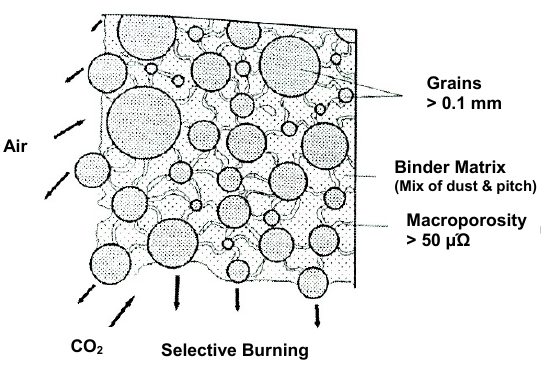
Figure 2. Anode consumption in the pot.